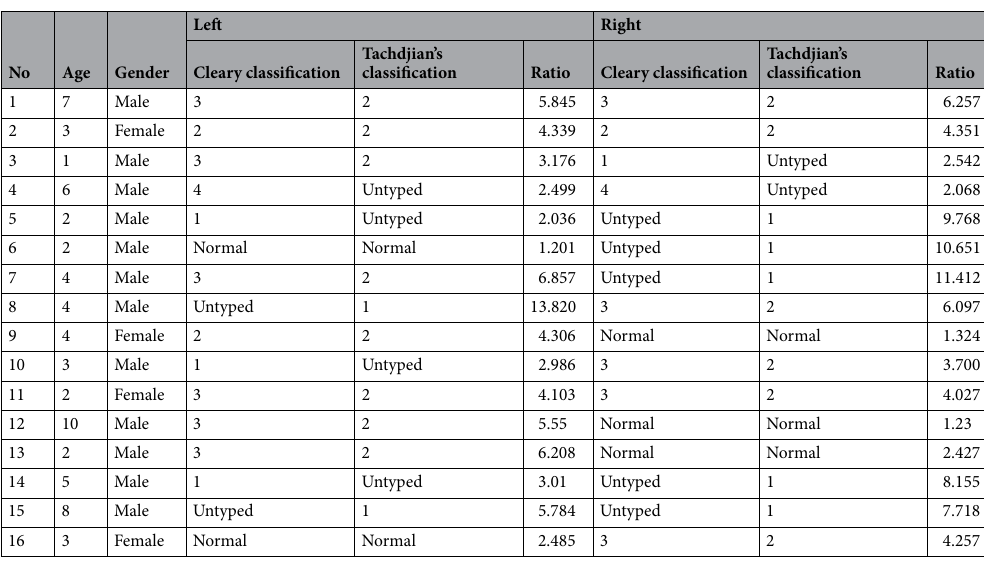
Table 2. Demographics information and imaging data for included cases.